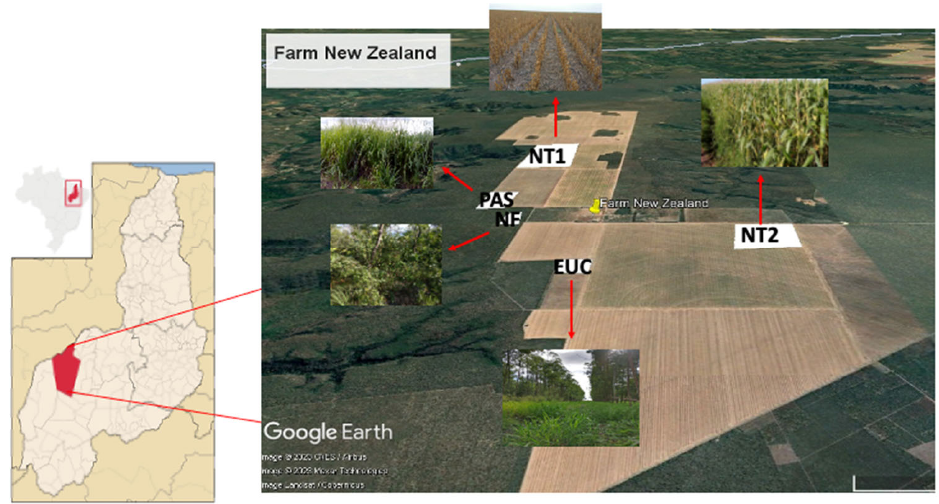
Figure 1. Map of Farm New Zealand showing the evaluated areas. PAS: Pasture species (Mombasa); NT1 and NT2: No-tillage system; EUC: Eucalyptus; NF: Native Cerrado forest.